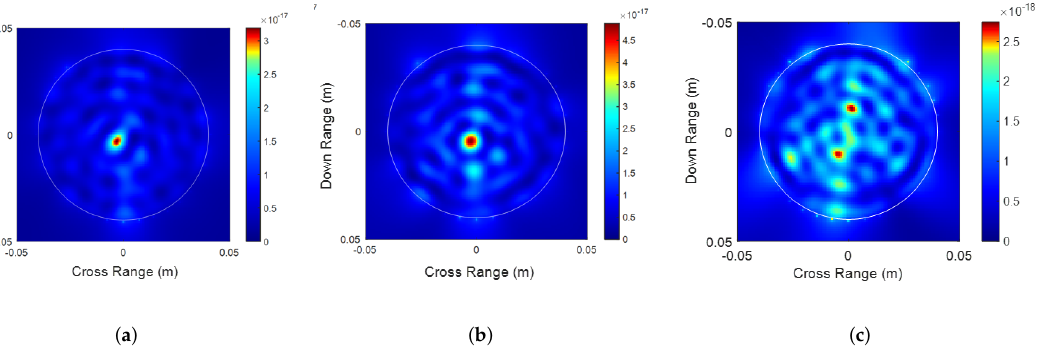
Figure 6. Time reversal imaging for ( a ) the small carrot, ( b ) the large carrot and ( c ) multiple